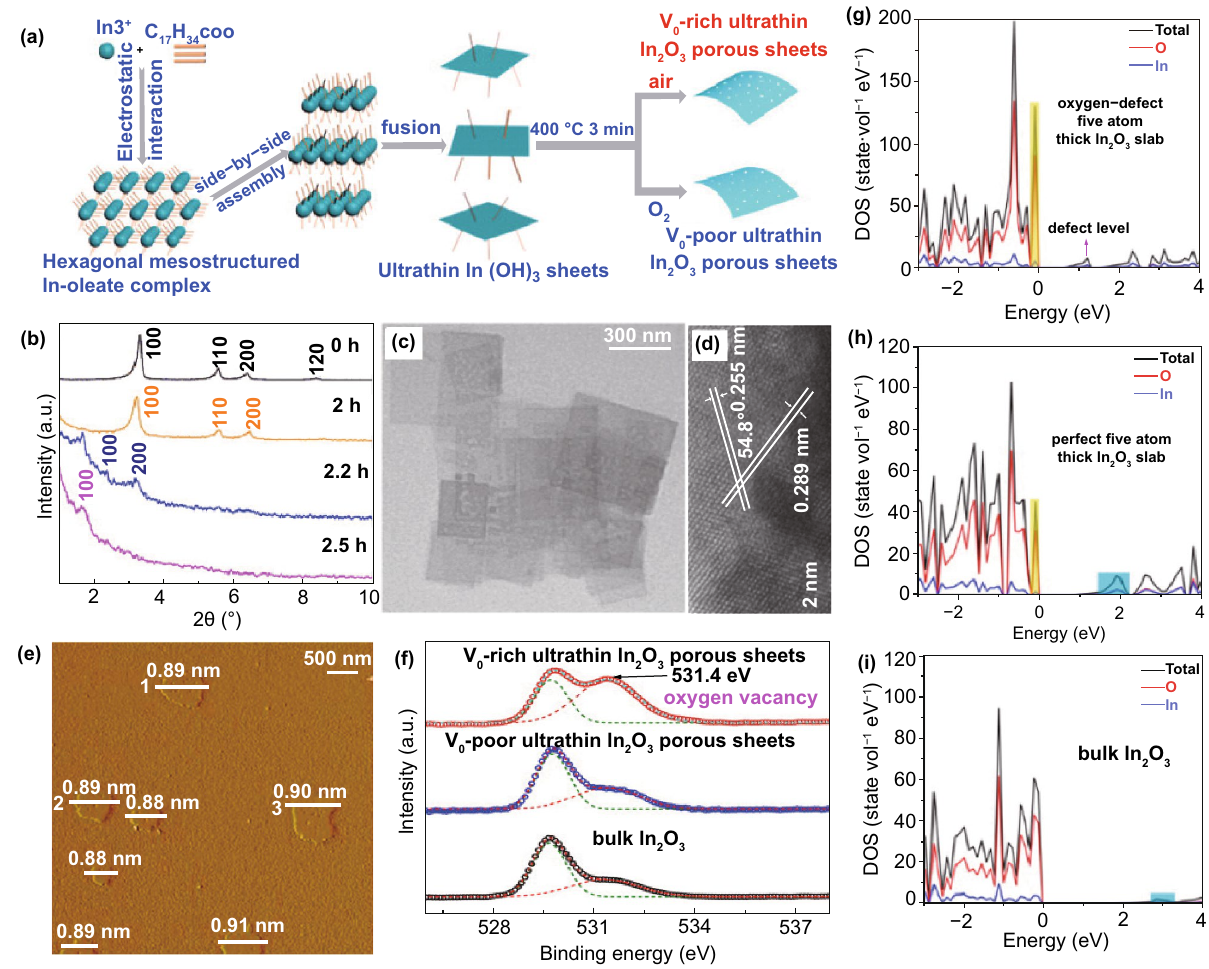
Fig. 12 a Scheme showing the development of VO‑rich/VO‑poor atomically thin In 2 O 3 porous NSs under special environment. b Time‑ dependent small‑angle XRD patterns for the as‑synthesized precursors. c–f Characterizations for the VO‑rich atomically thin In 2 O 3 porous NSs obtained via rapid thermal heat treatment of In(OH) 3 NSs in air. c , d TEM/HR‑TEM image. e AFM analysis. f O 1s XPS spectra. g Electron spins resonance spectrum. h Simulated DOS of O 2 defect five‑atom‑thickness In 2 O 3 slab. i ideal five‑atom‑thickness In 2 O 3 slab. Adapted with permission from Ref.